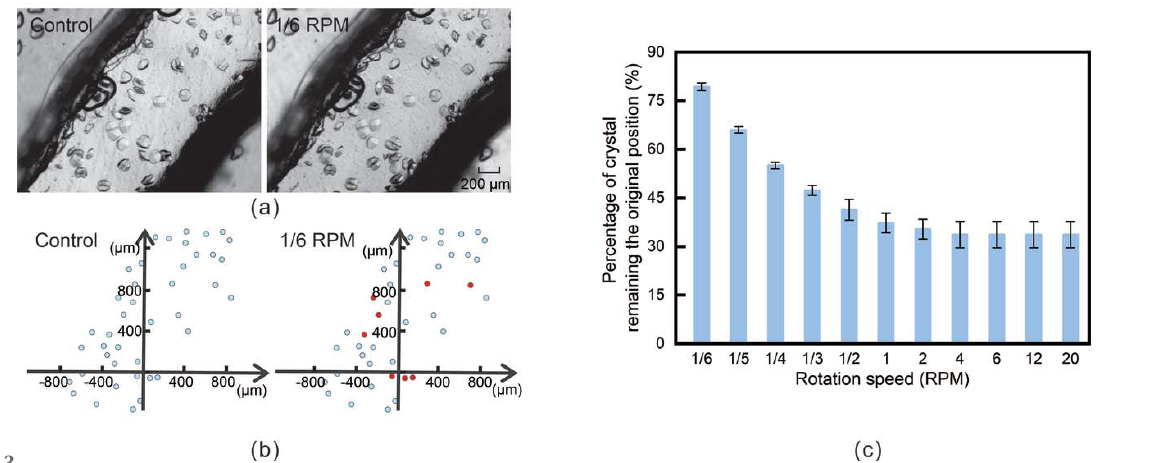
Figure 3 Analysis of crystal distribution. ( a ) Optical imaging of the crystal morphology and its distribution in the microfluidic channel before and after rotation at a speed of 1/6 RPM. ( b ) Schematic diagram of crystal positioning. ( c ) Percentage of crystals remaining at the initial